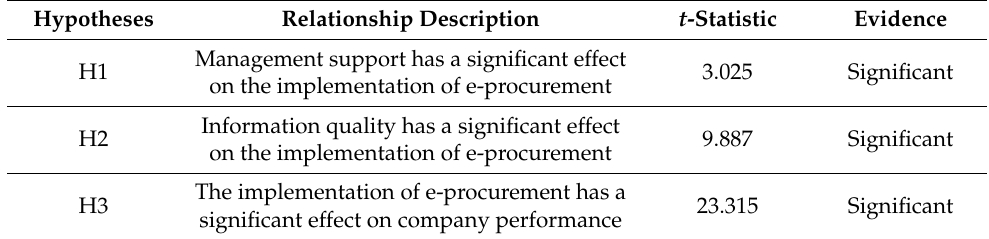
Table 10. Results of hypothesis